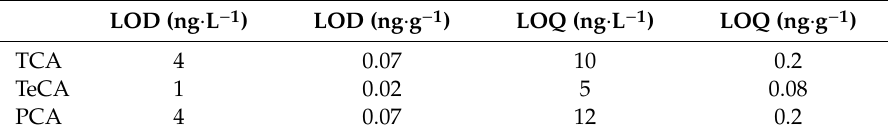
Table 5. Limits of detection and quantification for the method